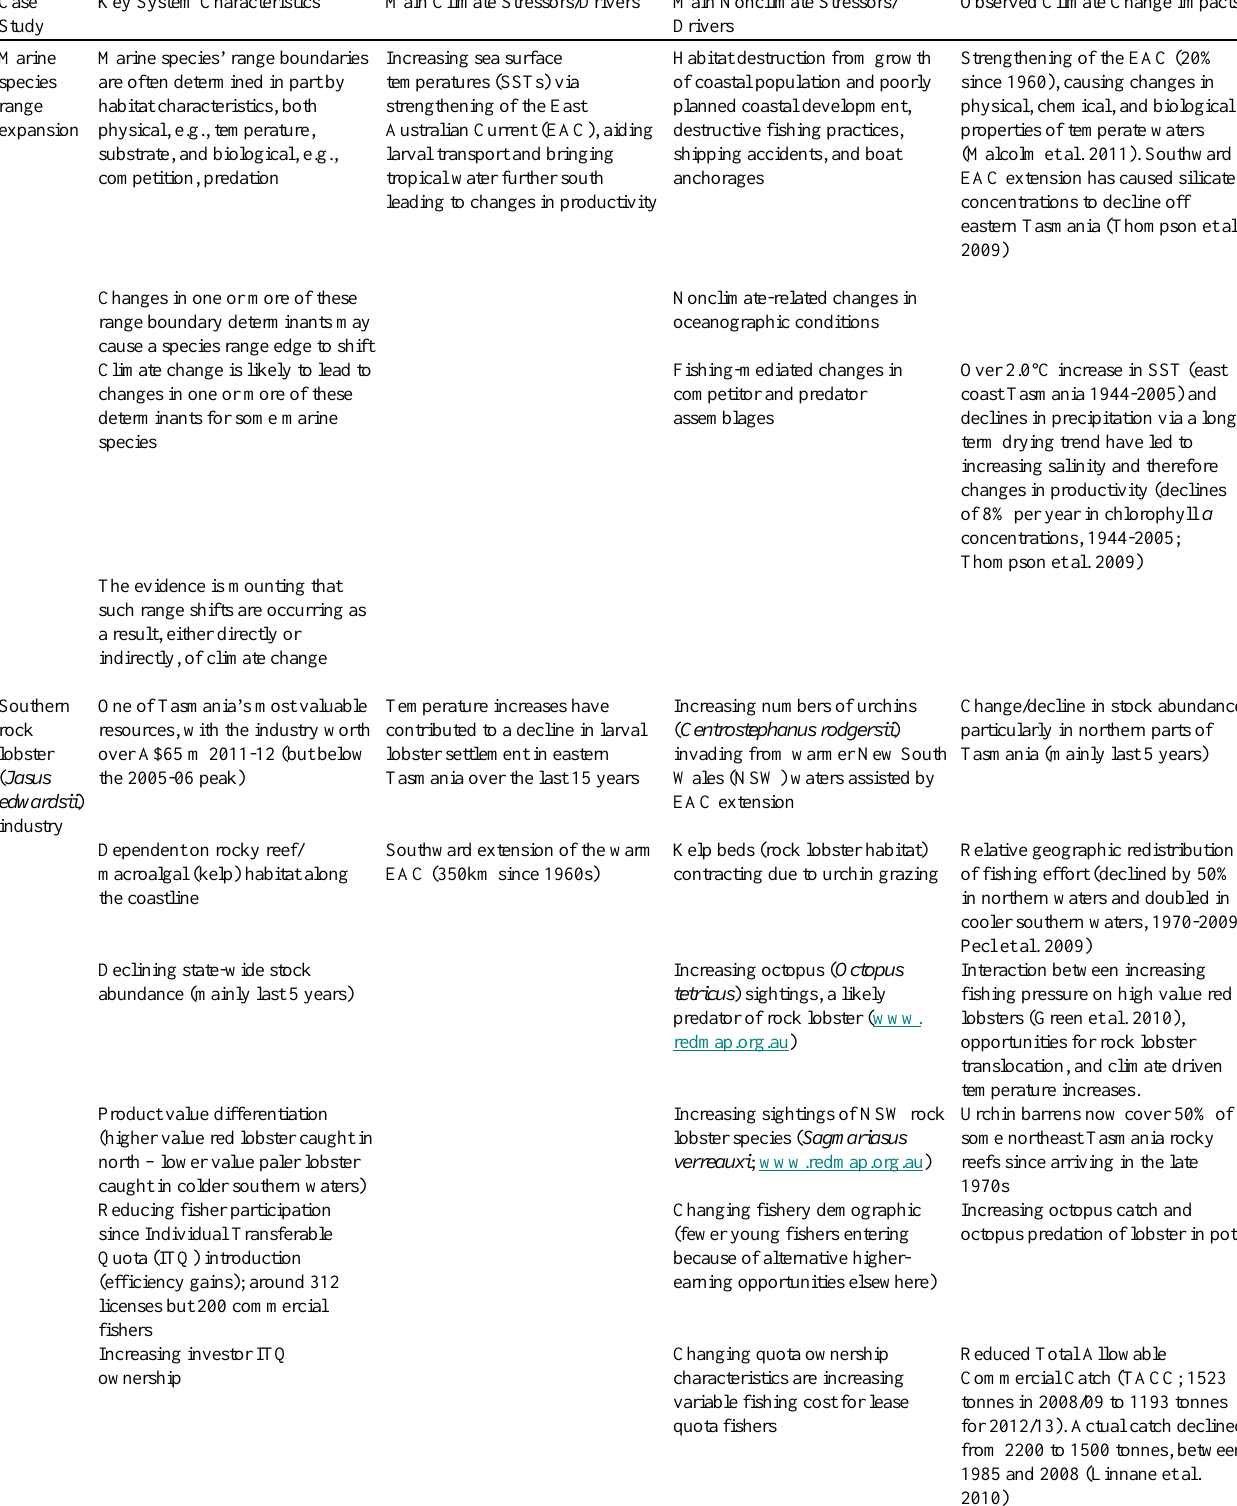
Table 1 . Case study descriptions: system characteristics, external drivers, and observed climate change